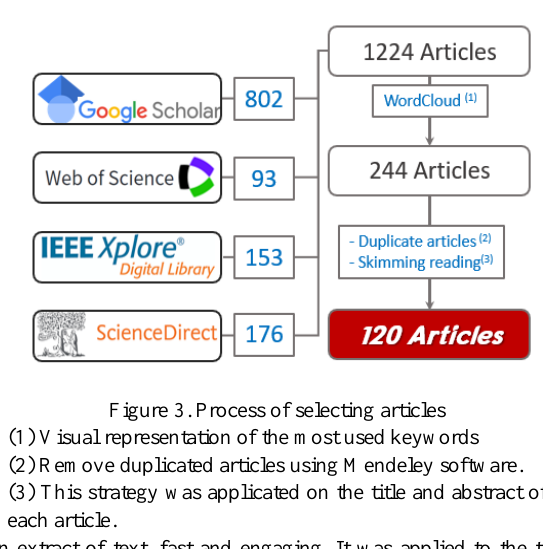
Figure 3. Process of selecting